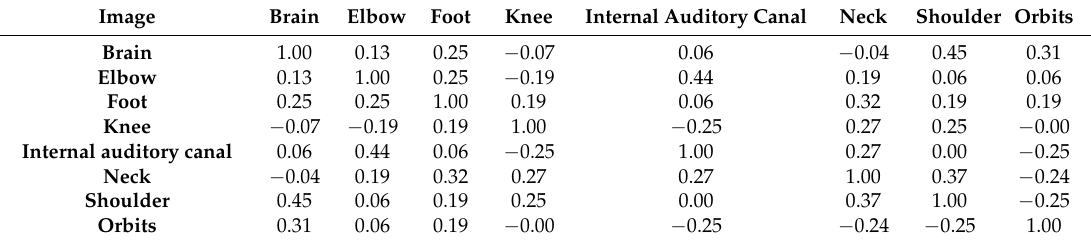
Figure 8. Some tested images: ( a ) Brain; ( b ) Elbow; ( c ) Foot; ( d ) Knee; ( e ) Internal auditory canal; ( f ) Neck; ( g ) Shoulder; ( h ) Orbits. Table 2. Values of the correlation coefficients between different images (32 bit).